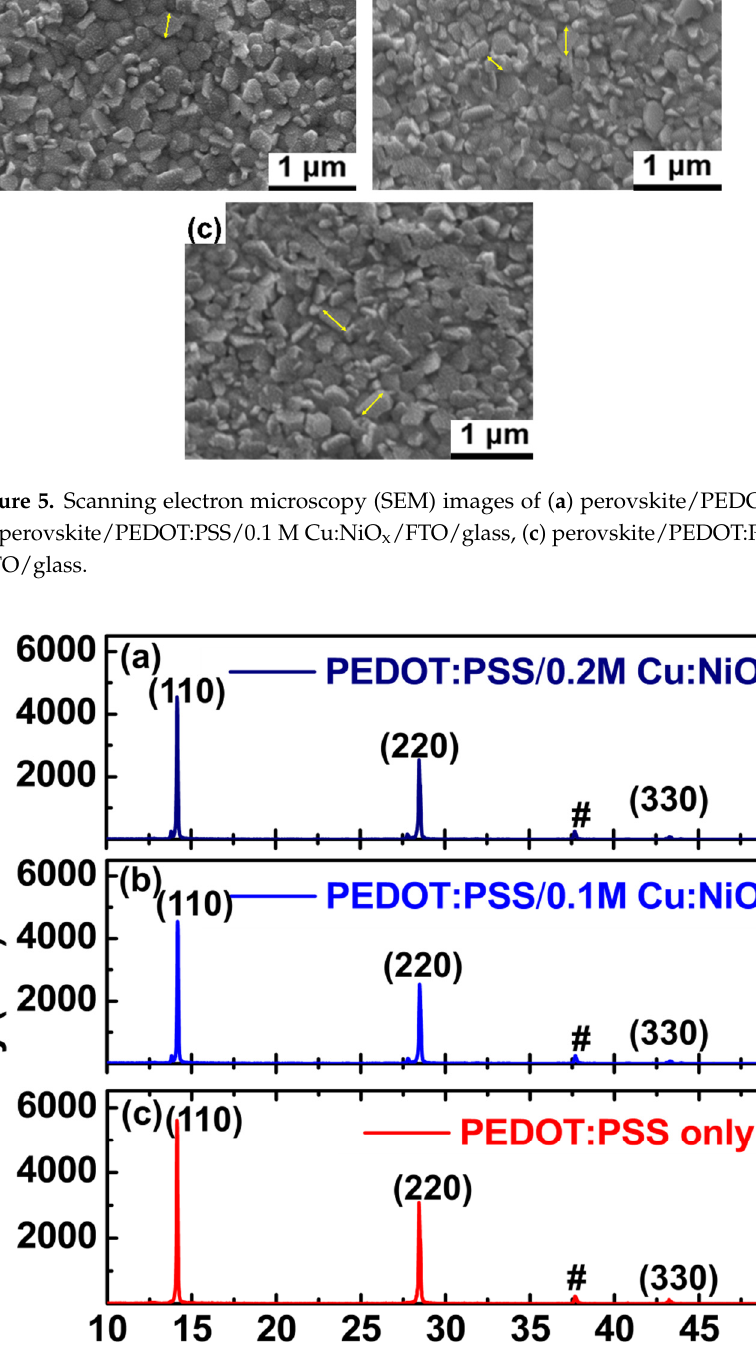
Figure 6. X-ray diffraction spectra of perovskite on ( a ) PEDOT:PSS/ 0.2 M Cu:NiO x /FTO/glass; ( b ) PEDOT:PSS/0.1 M Cu:NiO x /FTO/glass and ( c ) PEDOT:PSS/FTO/glass, respectively.